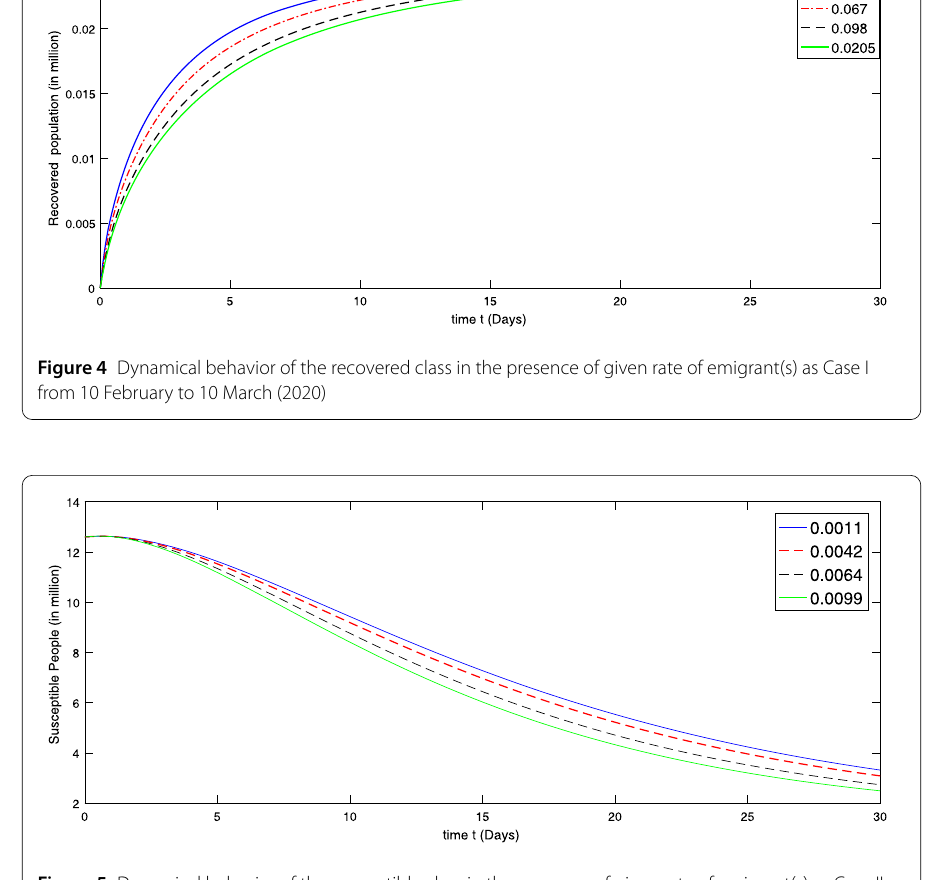
Figure 5 Dynamical behavior of the susceptible class in the presence of given rate of emigrant(s) as Case II from 10 March to 10 April